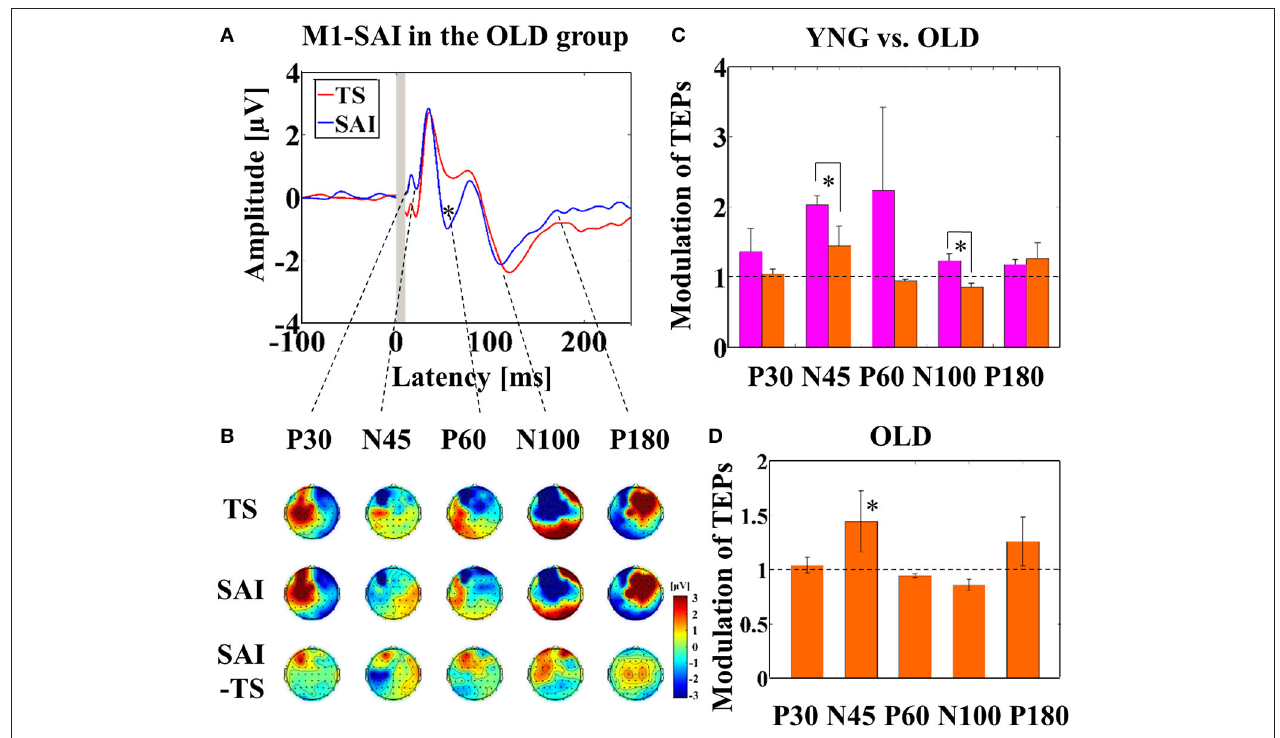
FIGURE 1 | Result of TEPs in M1–SAI paradigm. (A) The graph shows the TEP traces with individual somatosensory evoked potentials (SSEPs) subtraction. The graph depicts TEP traces averaged across the older participants for TS and SAI (ISI N20 + 2 ms) at the left central ROI. TMS was delivered at a time equivalent to 0 ms. (B) The illustration shows the EEG topographical plots for conditions of TS, SAI (ISI of N20 + 2), and the difference between TS and SAI obtained from M1–SAI experiment. Each vertical column depicts the TEP topoplots for P30, N45, P60, N100, and P180 component from left to right, respectively. (C) The bar graph shows the group differences between younger (pink bars) and older (orange bars) participants in the modulation of TEPs induced by M1–SAI. The cutoff of the graph is ratio of 1. Older participants demonstrates significantly lower modulation in N45 (t 22 = 5.485, p < 0.0001) and N100 (t 22 = 3.627, p = 0.001) TEPs in this paradigm. (D) The bar graph shows the modulation of TEPs within the older participants. The cutoff of the graph is ratio of 1. Older participants indicates significant modulation in N45 TEP (t 11 = 4.062, p = 0.002) by